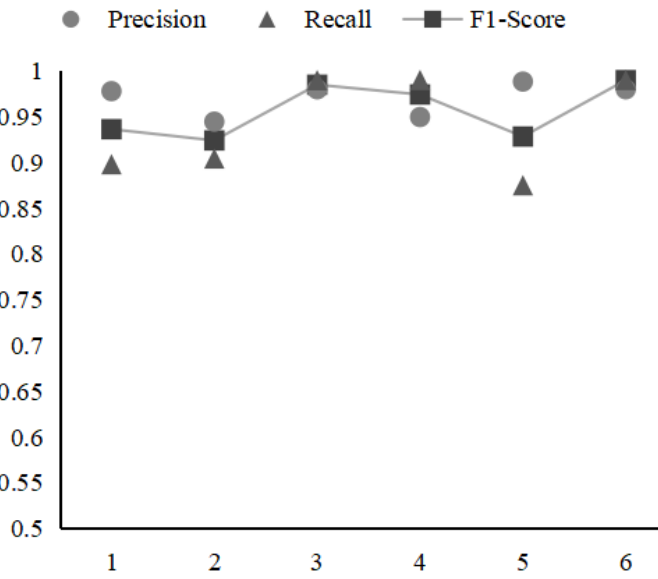
Figure 8. The impact of window size on performance of ConAnomaly.